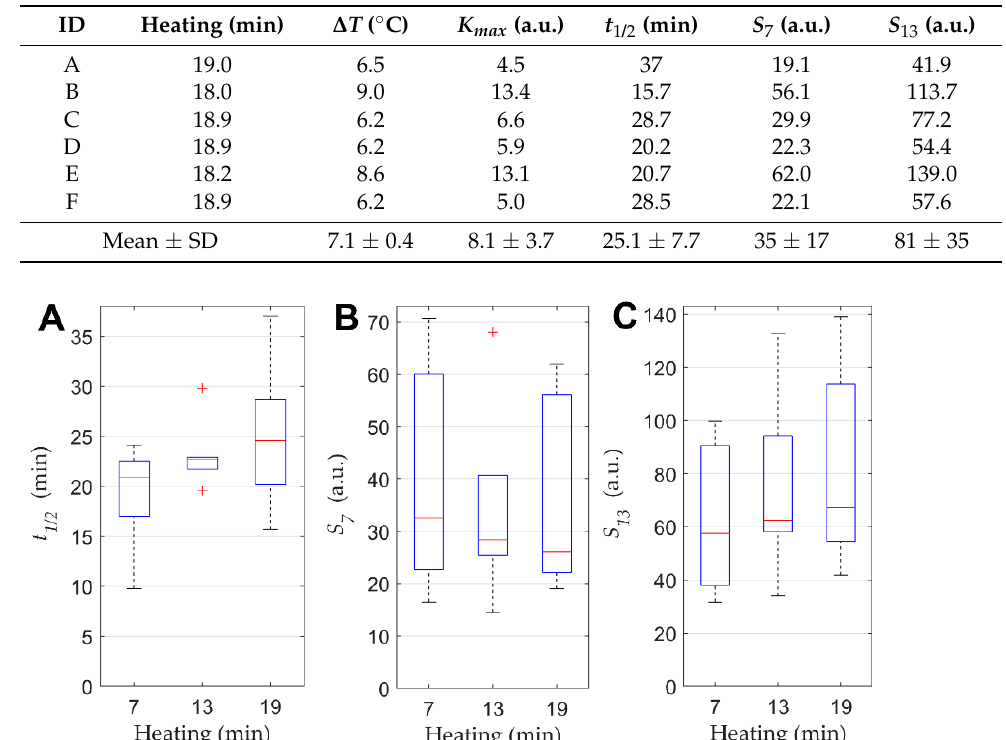
Table 4. Parameters of the perfusion reaction to local skin heating for 19 min.